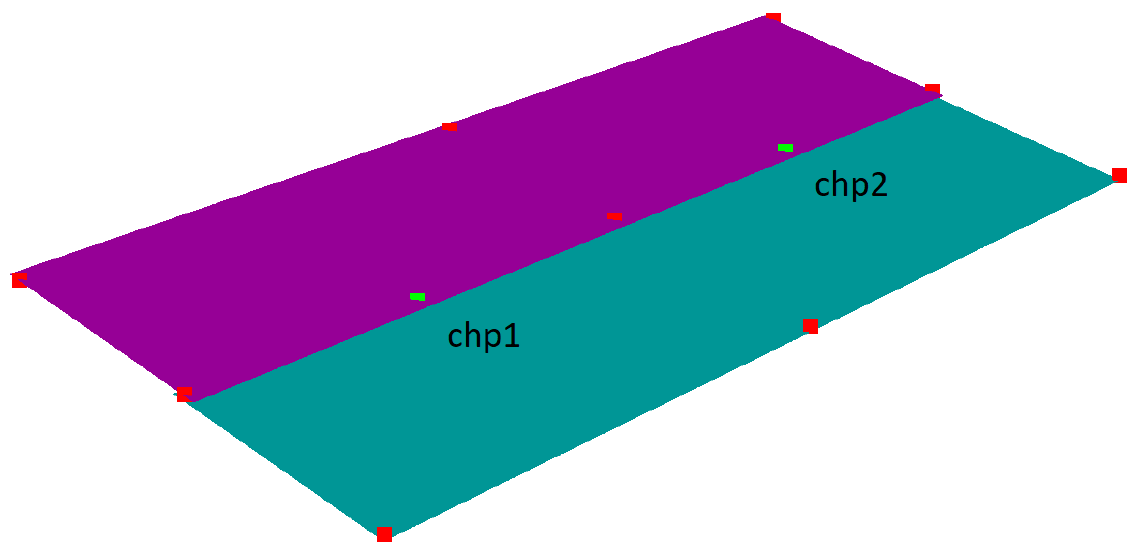
Figure 12. Two synthetic parallel strips with nine red GCPs and two green check points.